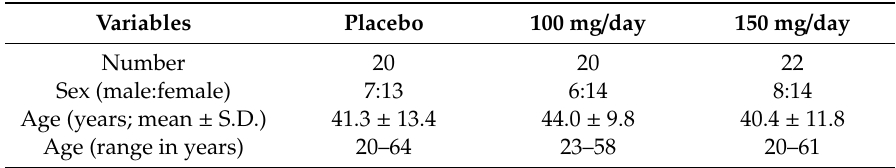
Table 1. Participant characteristics.